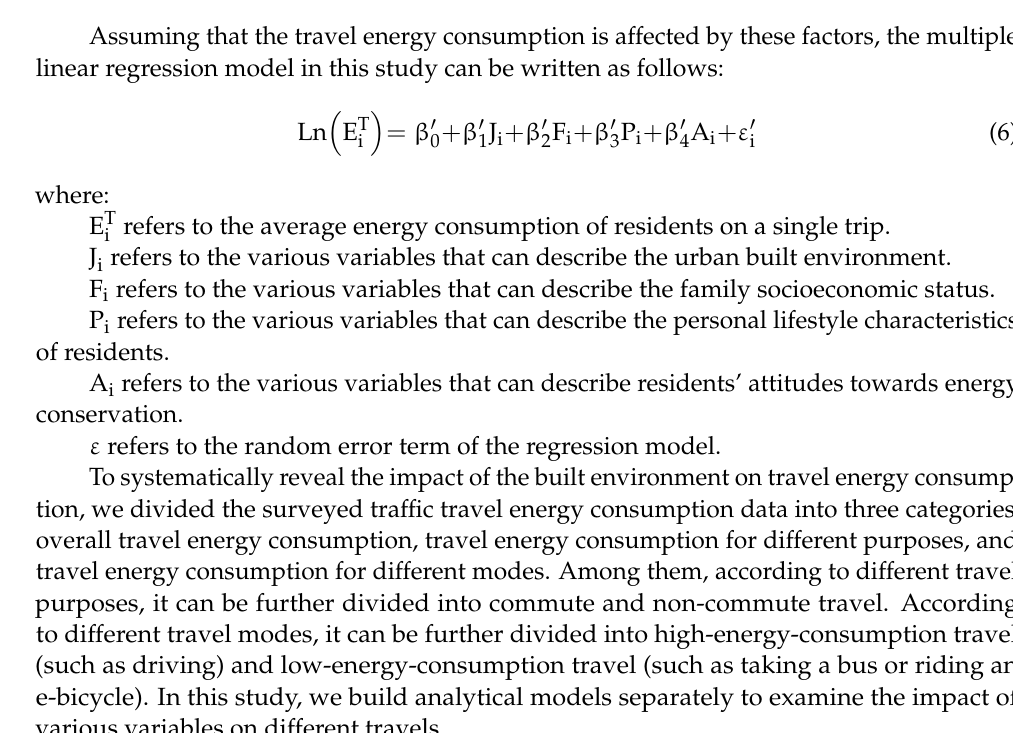
Figure 4. Conceptual framework describing the impact mechanism of built environment on travel energy consumption.